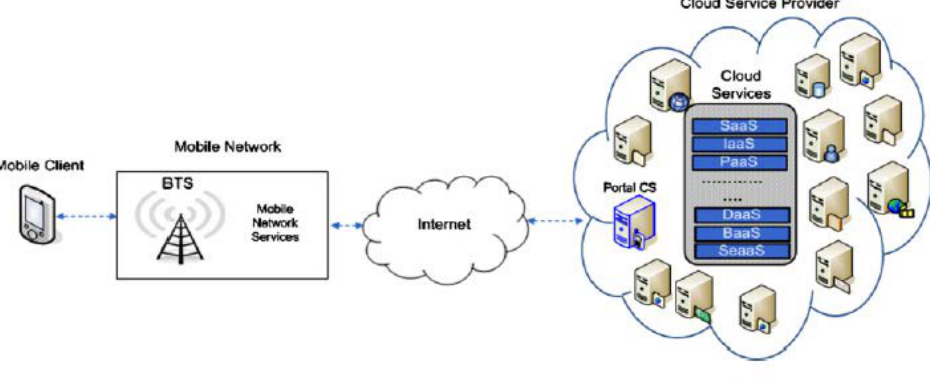
Figure 2 . Mobile cloud learning architecture (Khan, Kiah, Khan, & Madani, 2012).